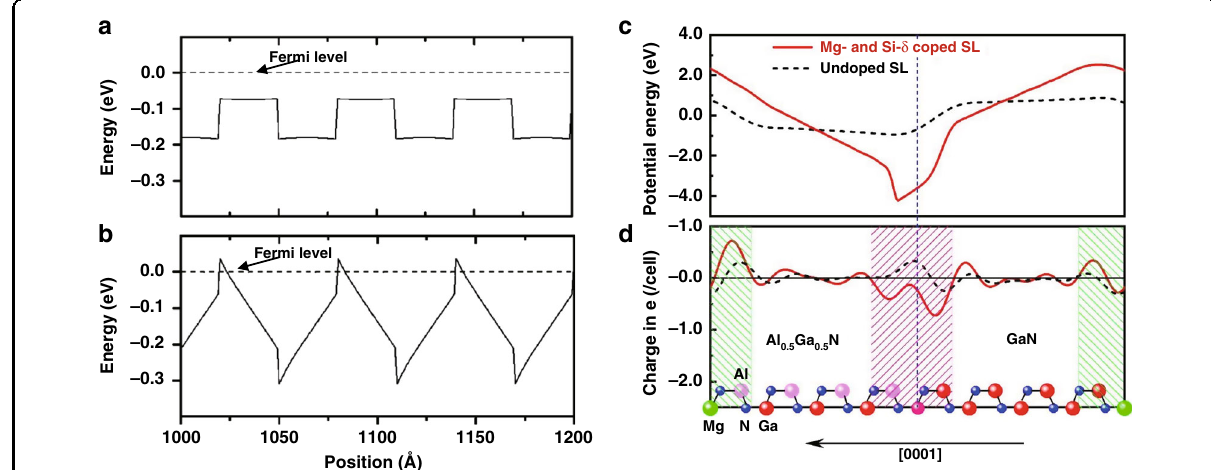
Fig. 11 The polarization fi eld effect on the energy band structures of Mg-doped AlGaN SLs. Calculated valence band diagram for Mg-doped Al 0.2 Ga 0.8 N/GaN SL in which the thickness of each layer is L = 30 Å, shown without ( a ) and with the polarization fi elds taken into account ( b ). The macroscopic averaged electrostatic potential ( c ) and macroscopic averaged differential charge density ( d ) of Mg- and Si- δ -codoped (solid lines) and undoped (dash lines) Al 0.5 Ga 0.5 N/GaN SLs plotted in the [0001] direction normal to the interface. Figures reproduced from a and b ref. 153 , © 1999 AIP Publishing; c and d ref. 155 , © 2009 AIP